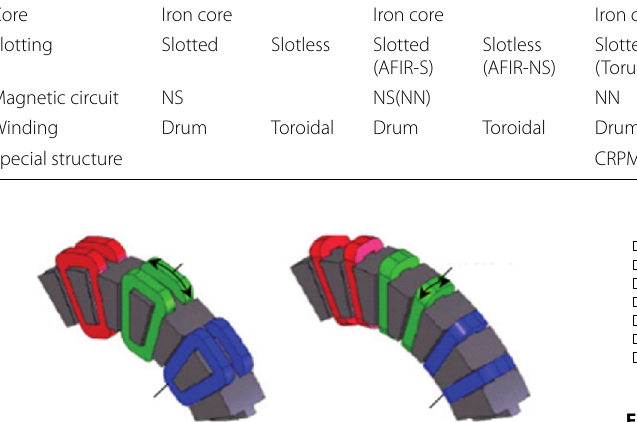
Figure 2 Winding structure of AFPMSM: a Drum and b Toroidal windings